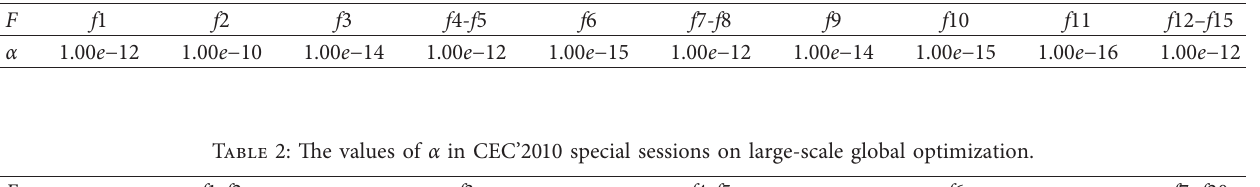
Table 1: The values of α in CEC’2013 special sessions on large-scale global optimization.